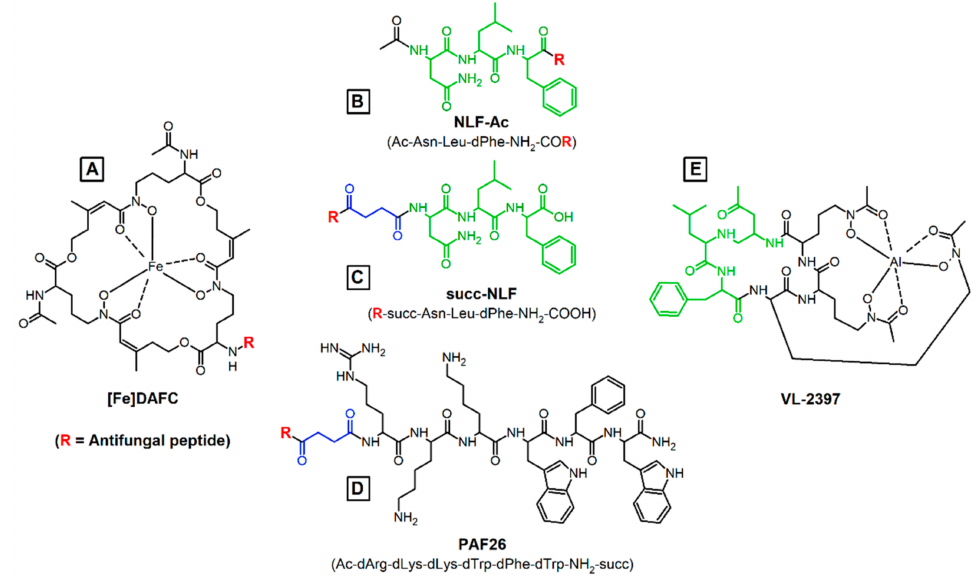
Figure 1. Chemical structures of the siderophore ( A ) [Fe]DAFC with its free amino group for coupling and conjugation of antifungal peptides. NLF peptide with two di ff erent modifications: ( B ) NLF-Ac directly coupled via carboxylic group and acetylated amino end; ( C ) succ-NLF with a free carboxylic acid and at the N-terminus succinyl group for coupling. ( D ) PAF26 in both variants, D-PAF26 (original) and L-PAF26 (for control), were also coupled via succinyl-linker to the amine of [Fe]DAFC. ( E ) The ferrichrome analog VL-2397 with the antifungal “backbone” in green. Red:Coupling site; Blue: succinylic